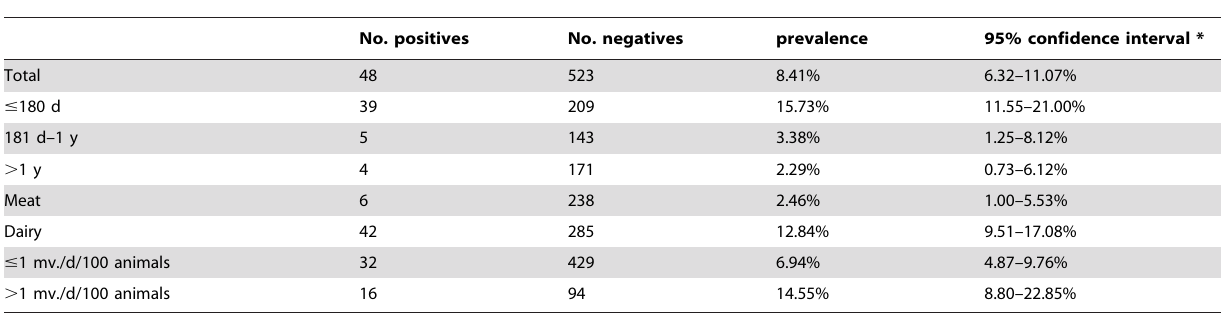
Table 2. Prevalences of animals with ESBL positive isolates.